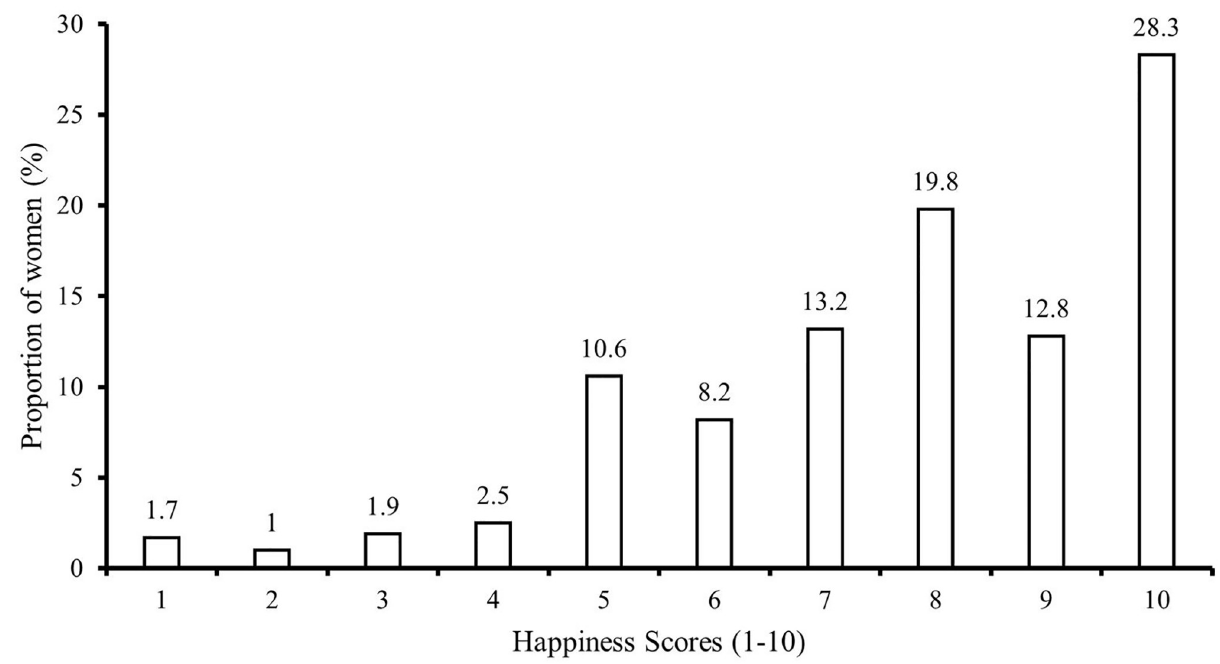
Fig 1. Distribution of happiness scores amongst 9,350 pregnant women in Al Ain, UAE. The Mutaba’ah Study.